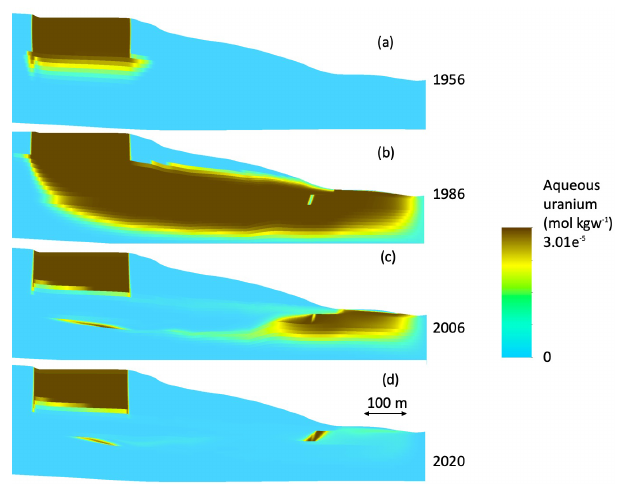
Figure 4. Plume profile of aqueous uranium concentration in the downstream of the F-Area study site from 1954 to 2020 in the base case simulation (the vertical exaggeration is ×